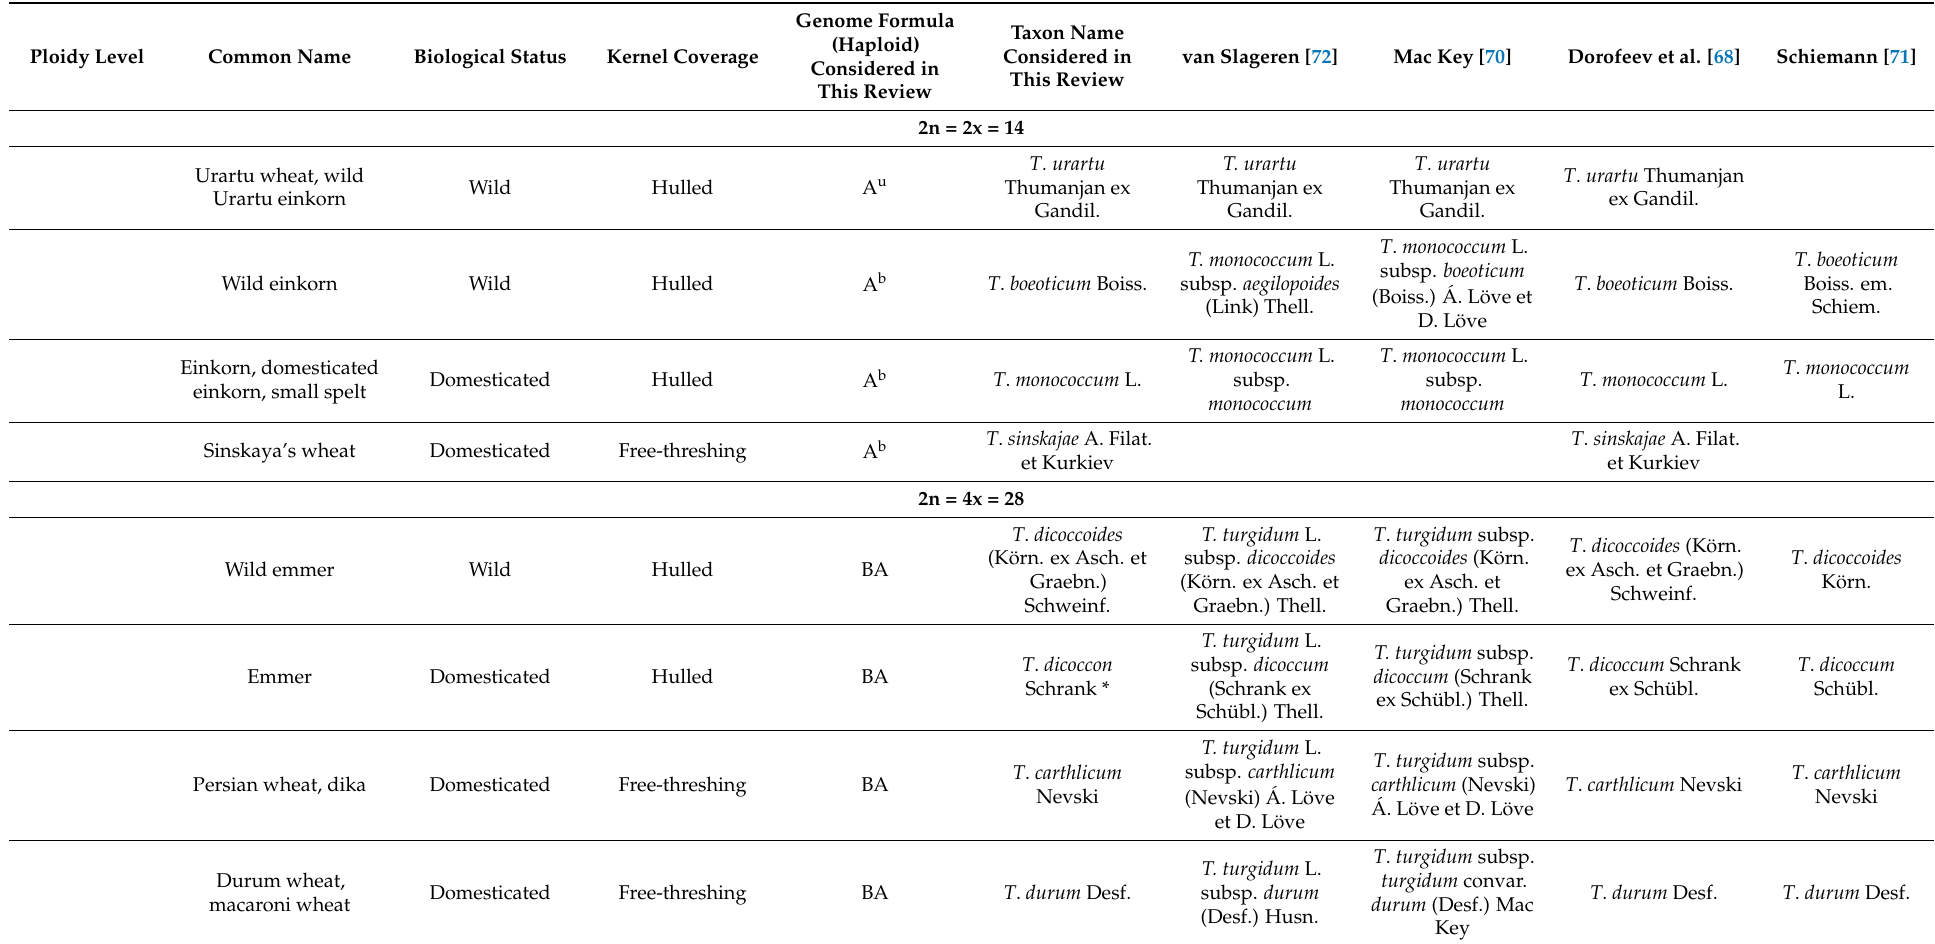
Table 2. Overview of selected wheat classifications. Botanical author abbreviations are according to the International Plant Names Index (IPNI; https://www.ipni.org accessed on 21 September 2021). * cf. Hammer et al.